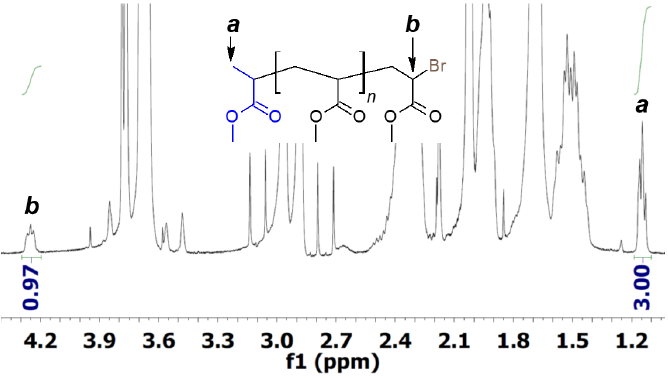
Figure 4. Determination of chain end-group fidelity by 1 HNMR for PMA–Br obtained via ATRP of MA by continuous feeding of Cu(I) activators. [ MA ] 0 : [ MBrP ] 0 : [ CuBr 2 ] 0 : [ Me 6 TREN ] 0 = 50 : 1 : 0.0025 : 0.005 at 60 ◦ C with 100mmol MA in 5mL of DMF; 0.04mmol CuBr/Me 6 TREN in 2mL MeCN was added in 2h. The conversion of monomers reached 86%, giving polymers with M n = 3700 and M w / M n =